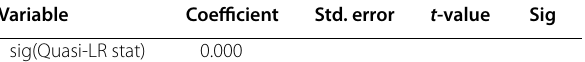
0.1, 20, 30, 40, 50). Source: =